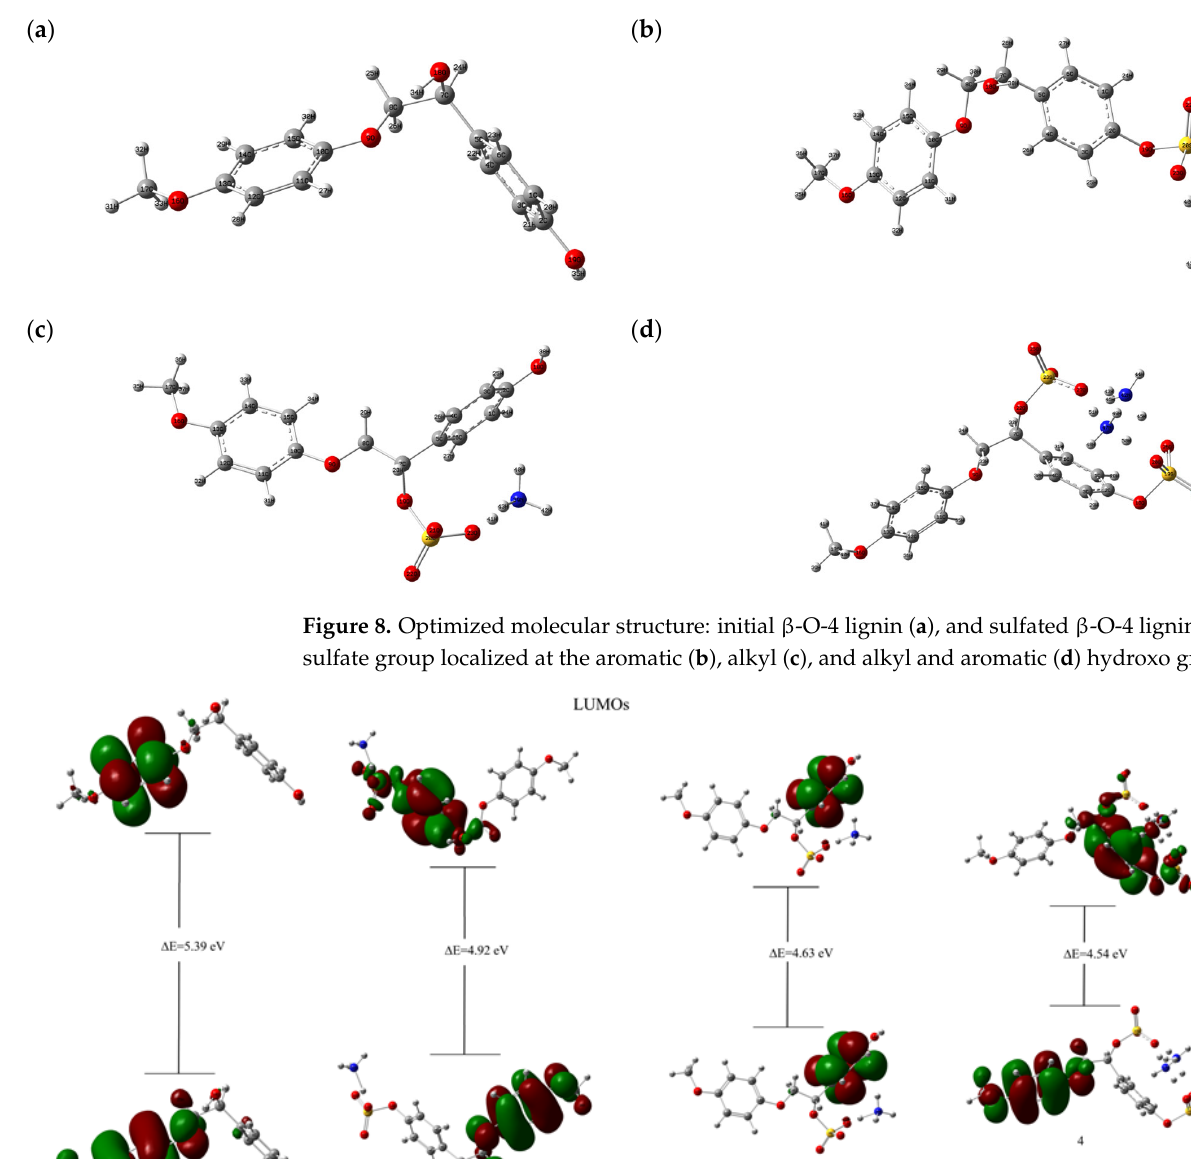
Table 3. Electronic properties of the molecules under study.